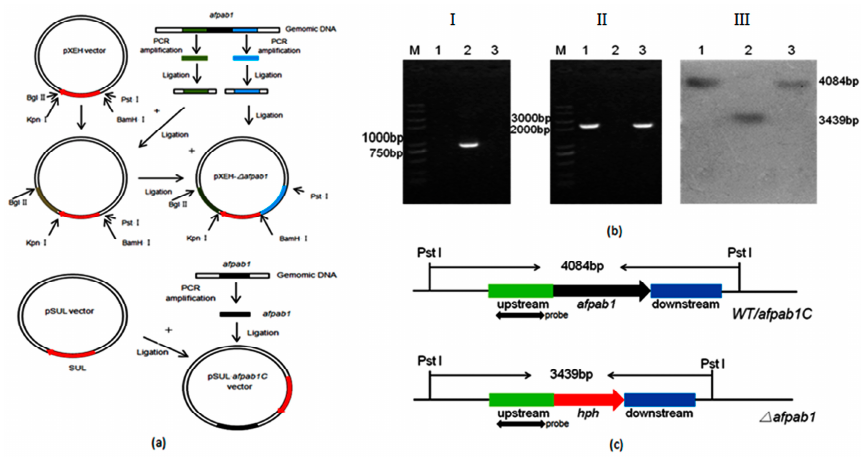
Figure 2. Deletion and reconstitution of afpab1 of A. fumigatus . ( a ) The constructed schematic of Δ afpab1 and afpab1C in A. fumigatus ; ( b ) Molecular analysis of WT, Δ afpab1 and afpab1C . Hph gene can be amplified from Δ afpab1 (I) but cannot be amplified from WT or afpab1C , and afpba1 gene can be amplified from WT and afpab1C (II) which cannot be amplified from Δ afpab1 . Genomic DNA digested with Pst I was probed with an upstream region of afpab1 to detect the Δ afpab1 , WT, and afpab1C (III); ( c ) Southern hybridization schematic diagram. M: DNA molecular size marker Trans 2K plus II; 1: WT; 2: Δ afpab1 ; 3: afpab1C . (Green: upstream fragment of afpab1 gene, Red: hph gene, Blue: downstream fragment of afpab1 gene).